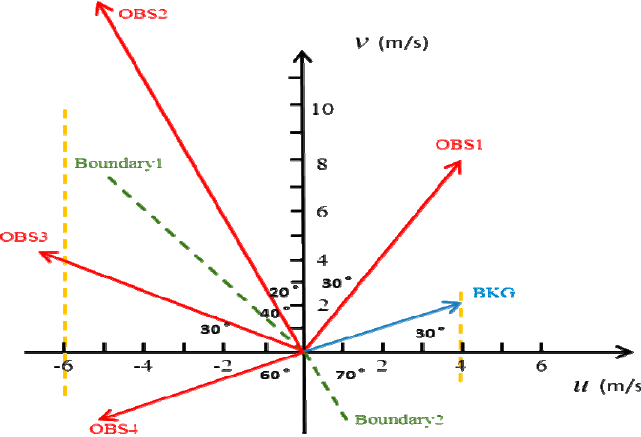
Figure 2. Diagram of background wind vector BKG and the observation wind vectors (OBS1, OBS2, OBS3, and OBS4) used to present the difference between thequality control procedures, QC_co and QC_al, of SAR_uv (standard assimilation method in theWeather Research and Forecasting Model Data Assimilation system (WRFDA), assimilating SAR wind observation in the form of u and v components) and SAR_sd (new assimilated method, assimilating SAR wind observation in the forms of wind speed and direction). Table 1. The detail value of the background and four kinds of observations.